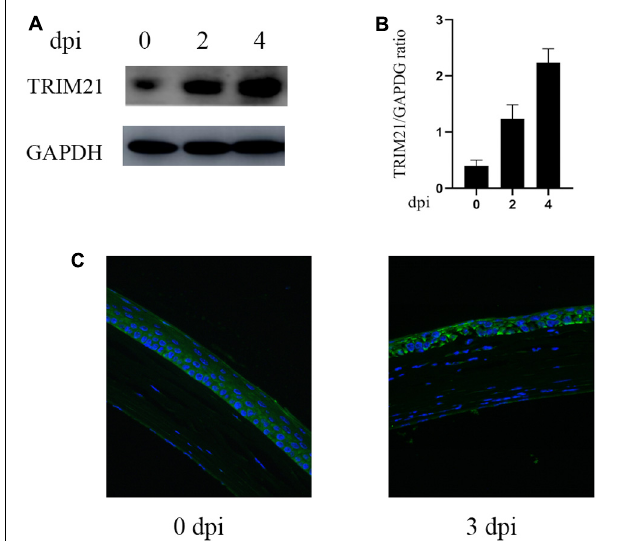
FIGURE 1 | Abnormal expression of TRIM21 in C57BL/6 mouse cornea after HSV-1 infection. (A) The protein expression level of TRIM21 was examined by western blotting in corneas at 0, 2, and 4 days post HSV-1 infection (dpi). Three corneas were used per experiment. (B) Relative integrated density values quantitated TRIM21 protein levels after normalization to GAPDH. Data were representative of three individual experiments and represented as the mean ± SD. (C) At 0 and 3 dpi, the expression of corneal TRIM21 was evaluated by immunofluorescent staining. TRIM21 staining showed green fluorescence, and nuclear staining showed blue fluorescence. Magnification: 400 ×